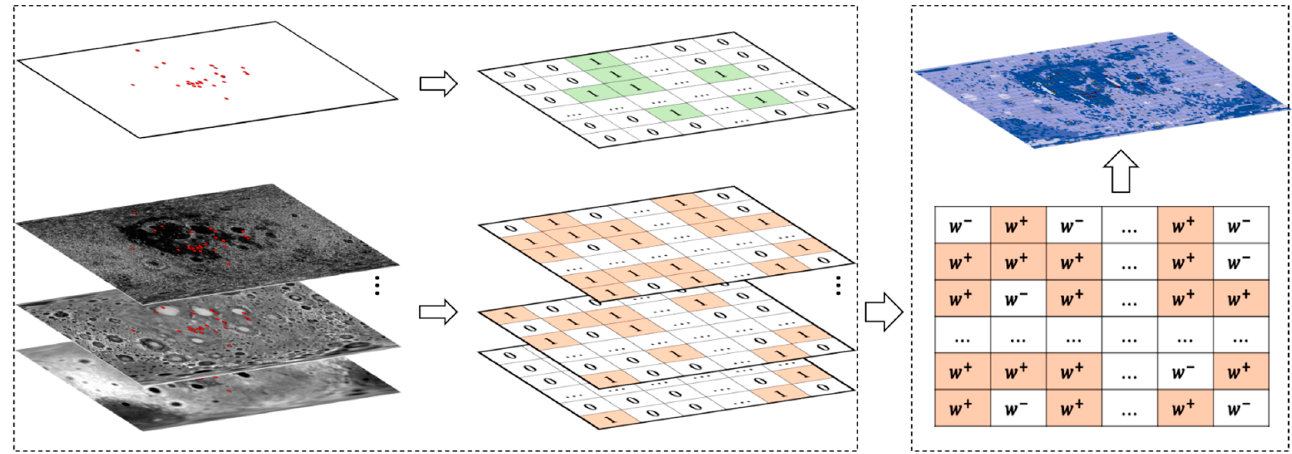
Figure 3. Schematic diagram of simulating landing zones calculations using the weights of evi- dence.( The red dots in the picture represent the landing zones.) (The red dots in the picture represent the landing